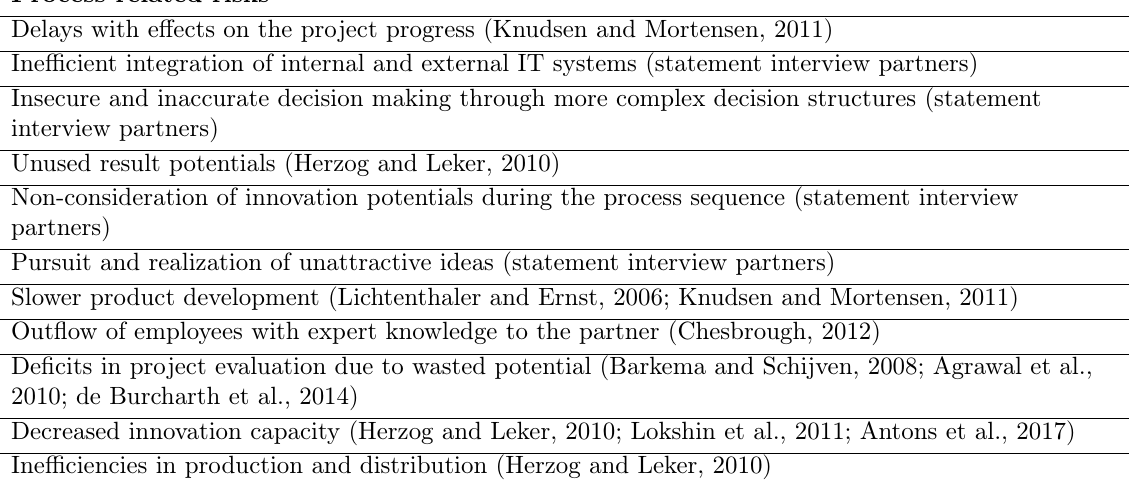
Table 4. Process-related risks of open innovation. Process-related